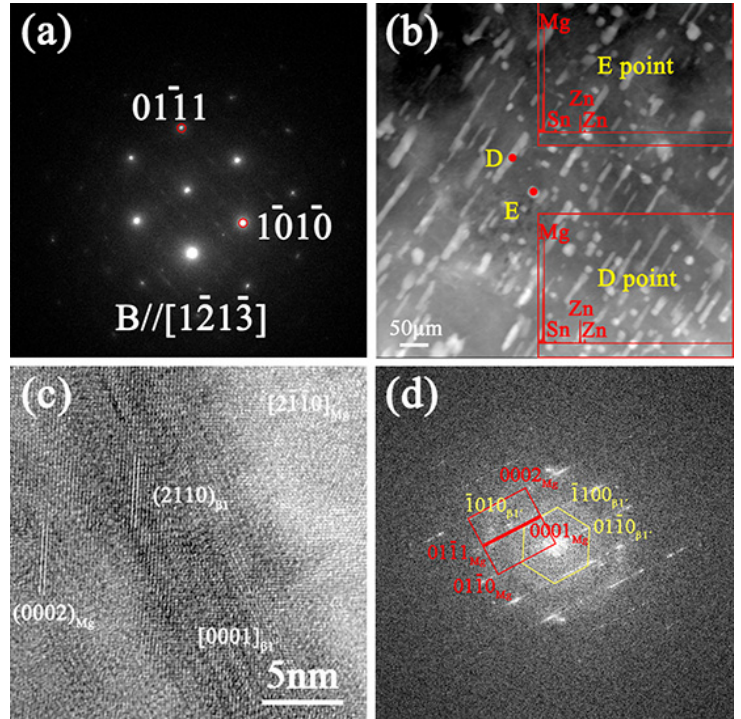
Figure 7. TEM micrographs of the single-aged ZTM641-1Al alloy, ( a ) Diffraction spots of the matrix, ( b ) HAADF-STEM, taken along the (cid:4670)1 2 (cid:3364)1 3 (cid:3364)(cid:4671) α -Mg zone axis, inset: corresponding EDS results of the points ( c ) HRTEM image of the β 1 ’-MgZn 2 phase and ( d ) corresponding FFT pattern of ( c ). According to the incident beam parallel to (cid:4670)1 2 (cid:3364)1 3 (cid:3364)(cid:4671) α -Mg , Figure 7b shows that a small